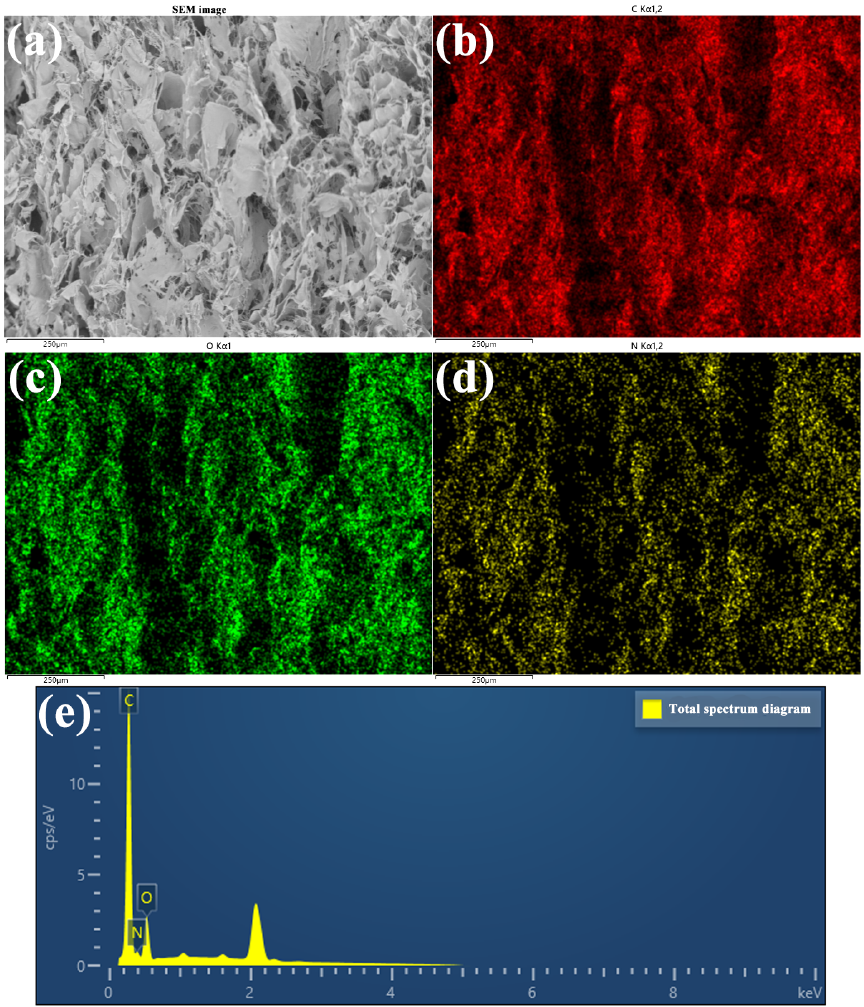
Figure 5. Element mappings of CCNF/ANF-5 sample: ( a ) Selective area image, ( b ) C element, ( c ) O element, ( d ) N element, and ( e ) total spectral distribution.